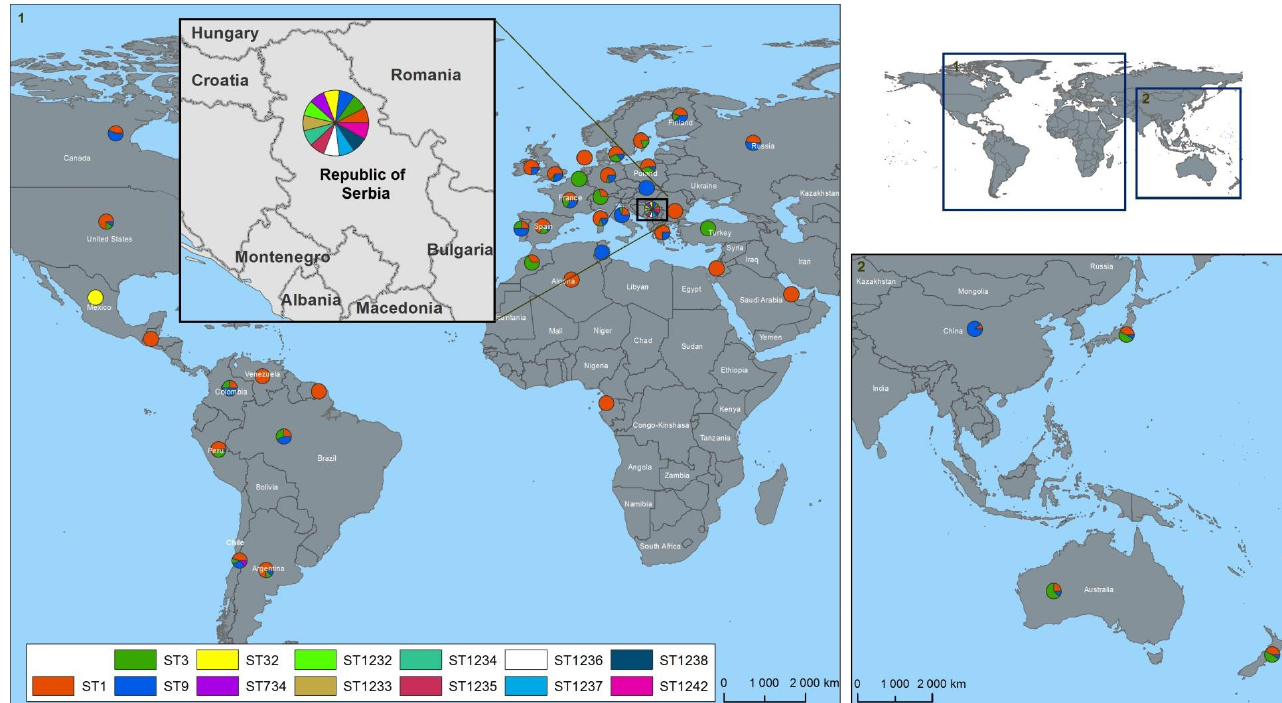
Figure 1. Location of the study area. The territory of the Republic of Serbia is illustrated in a separate square. The L. monocytogenes strains of different STs are highlighted in the colored circles: red — ST1, green — ST3, blue — ST9, yellow — ST32, plum — ST734, lime — ST1232, brown — ST1233, teal — ST1234, maroon — ST1235, white — ST1236, azure — ST1237, hunter green — ST1238, and hot pink — ST1242.